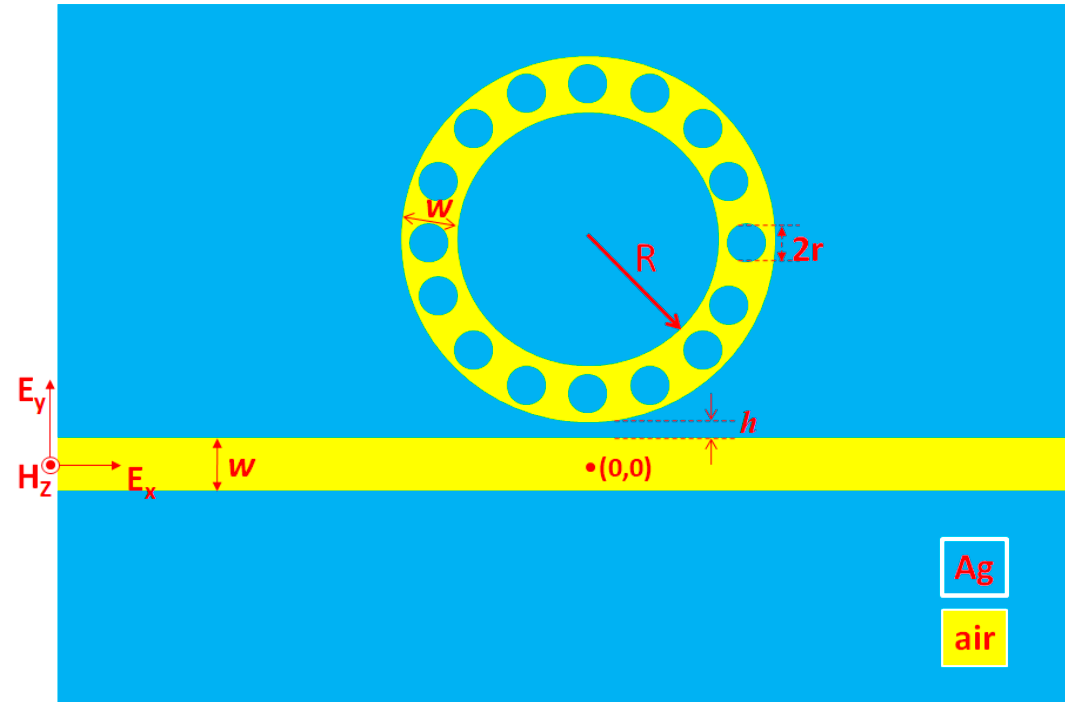
Figure 1. Schematic diagram of the proposed plasmonic band-stop filter, which is composed of a straight waveguide (width w ), a laterally coupled nanoring (width w and core radius R ) including sixteen silver nanorods in the nanoring. The silver nanorods (radius r ) uniformly distribute in the nanoring. The gap between the nanoring and the straight waveguide is h . The origin point (0,0) of the simulation model is located at the middle-end of the straight waveguide.